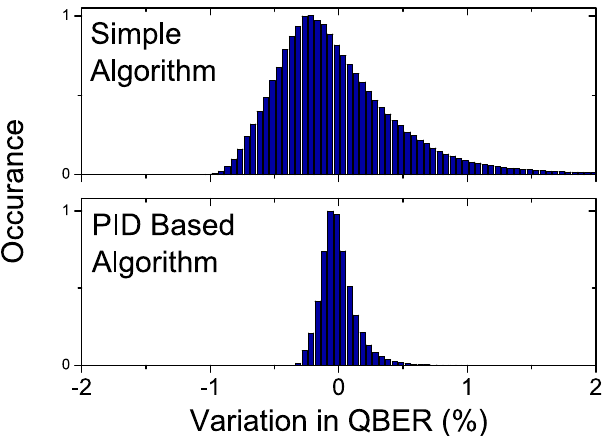
Figure 3. Histogram of QBER variation from the mean over time, using the newly developed PID based stabilisation algorithm (lower) as compared to the previous simple algorithm